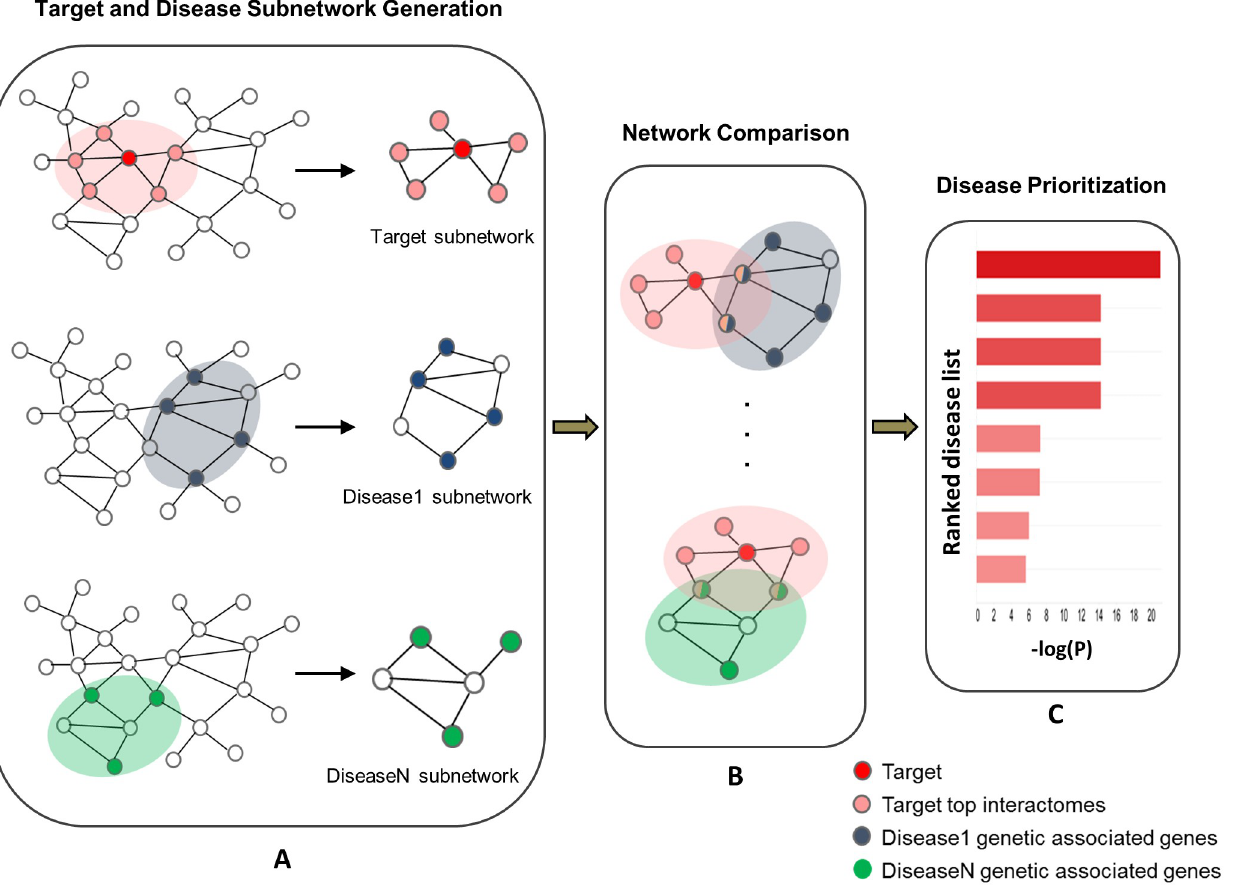
Fig 1. Workflow of network-based approach for indication expansion.